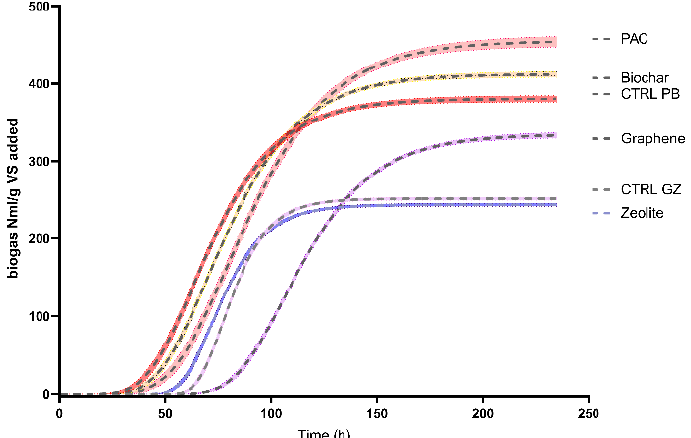
Figure 2. Cumulative predicted (as per the Gompertz model) values of biogas produced for the tested materials. CTRL-PB is referred to as the control for the PAC and biochar added tests, CTRL- GZ as the control for graphene and zeolite added reactors. Least square regression method, with Rsquared > 0.97, 95% CI.